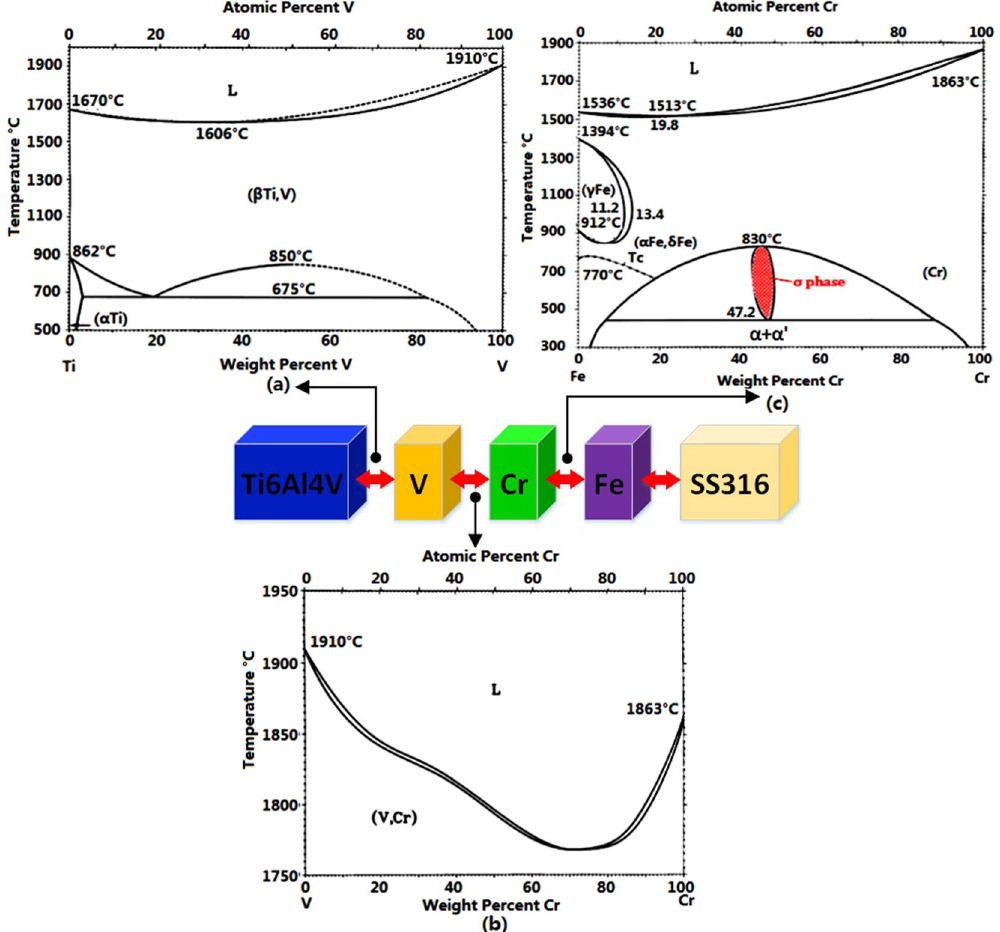
Figure 2. Binary alloy phase diagram of ( a ) Ti-V 32 ; ( b ) V-Cr 33 ; ( c ) Fe-Cr 34 ; and ( d ) composition